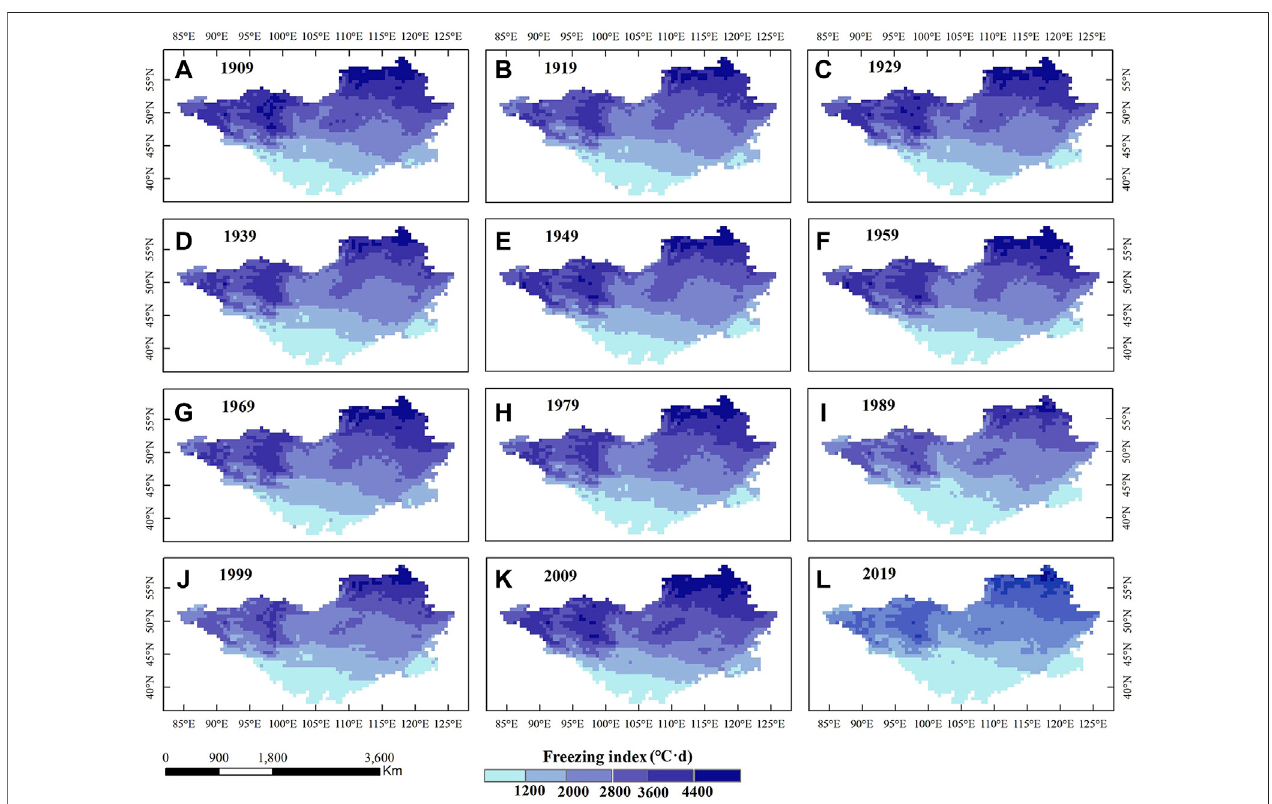
FIGURE4| DecadalspatialchangesintheairfreezingindexontheMongolianPlateaufrom 1901to2019.Labelslike (A – L) representthespatial variationoftheair freezing index for each decade from 1901 to